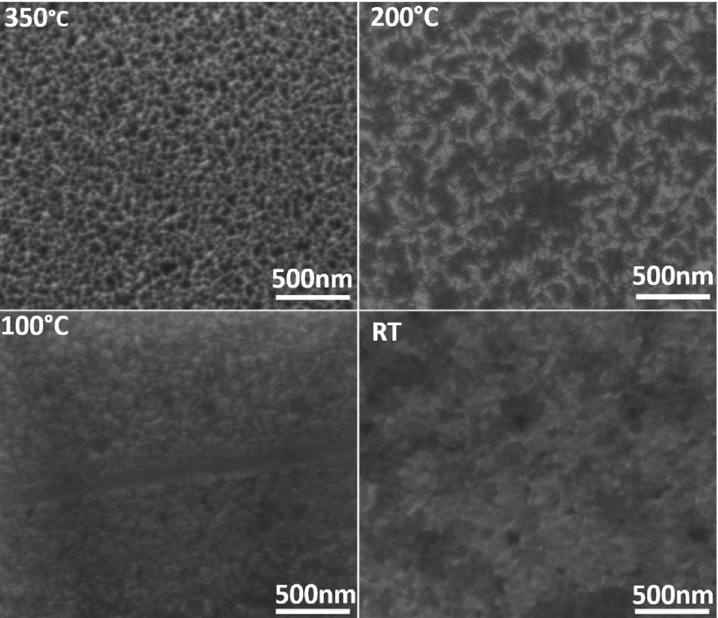
Figure 3. SEM images of ZnO thin films for different deposition temperatures.